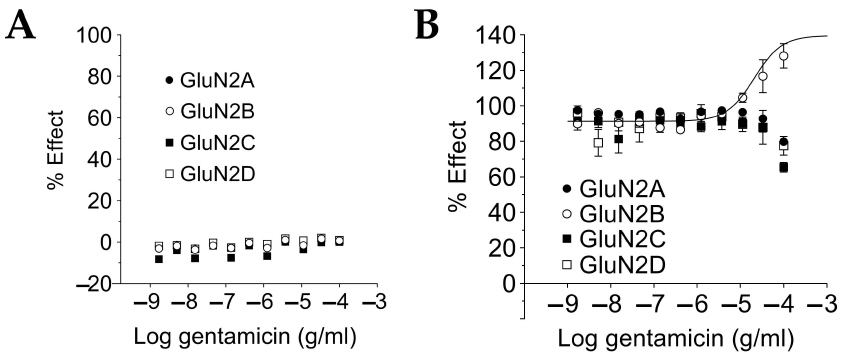
Figure 3. ( A ) Gentamicin had no NMDAR agonist effect. Gentamicin CRC was performed in absence of L-glutamate by FLIPR calcium assay, using the CHO cell lines expressing the indicated heterodimeric NMDAR. Gentamicin did not increase [Ca 2+ ] in at any tested concentration and in any cell line, indicating that it cannot ne substituted for L-glutamate in the activation of NMDARs. Data are mean ± SEM, n = 6. ( B ) Gentamicin was a positive modulator only at GluN1-GluN2B subtypes in the presence of 10 µ M L-glutamate. A second gentamicin CRC was run in similar FLIPR calcium assay conditions as those for the experiment illustrated in the text, but in the presence of 10 µ M L-glutamate. Gentamicin increased the [Ca 2+ ] in only in the cell line expressing the GluN1-GluN2B subtype, eliciting a maximal response of 128% at 100 µ g/mL gentamicin, with a calculated EC 50 of 21 µ g/mL. Data are mean ± SEM, n =